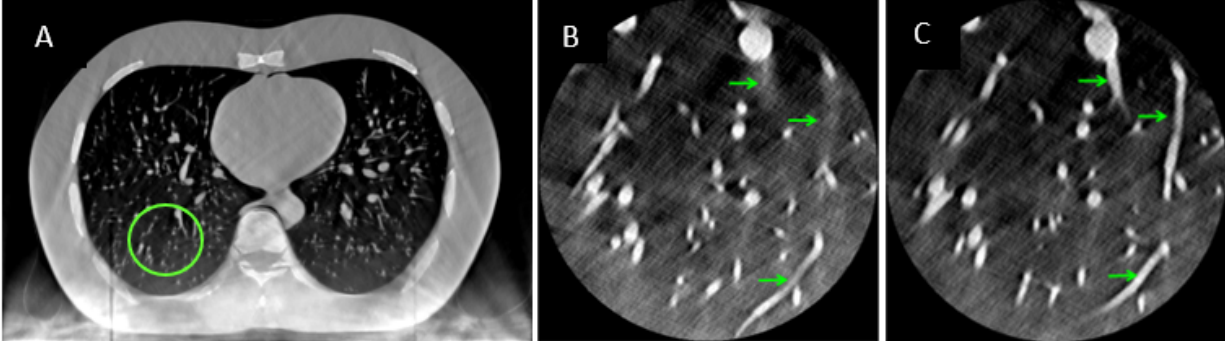
Figure 4. ( A ) A 500 mm FOV image of the chest phantom after data fusion. ( B , C ) Pre- and post- calibration 50 mm FOV (0.098 mm pixel) CT–CDI fused images of a region highlighted by the green circle in ( A ). Arrows point to the difference in the visualization of vessel structures before and after the iterative calibration.